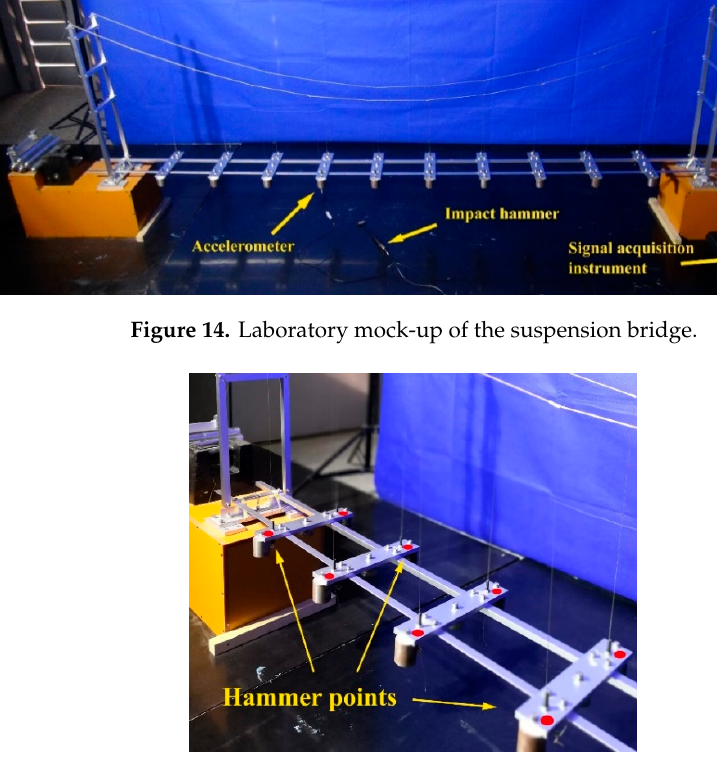
Figure 15. Hammer points on the deck.